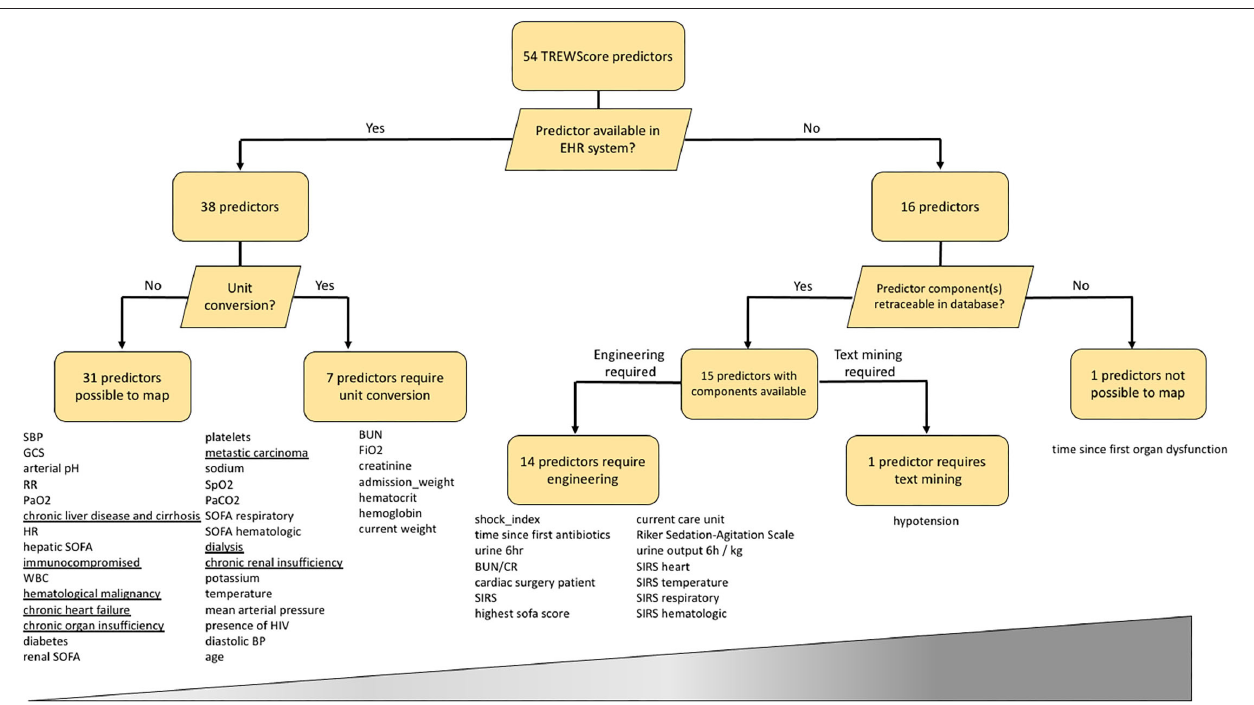
FIGURE 1 | Mapping of the 54 TREWScore predictors to the UMC ICU database. Predictors are listed below each end-node. The increasing width of the bar represents the difficulty scale from easy to hard of mapping each predictor category. Underlined predictors are within 24h documented in the UMC ICU EHR system and therefore not readily available at ICU admission. EHR, Electronic Health Record; SBP, Systolic Blood Pressure; GCS, Glasgow Coma Scale; RR, Respiratory Rate; HR, Heart Rate; SOFA, Sequential Organ Failure Assessment; WBC, White Blood Cell count; MAP, Mean Arterial Pressure; BP, Blood Pressure; BUN, Blood Urea Nitrogen; BUN/CR, BUN Creatinine Ratio; SIRS, Severe Inflammatory Response Syndrome; HIV, Human Immunodeficiency